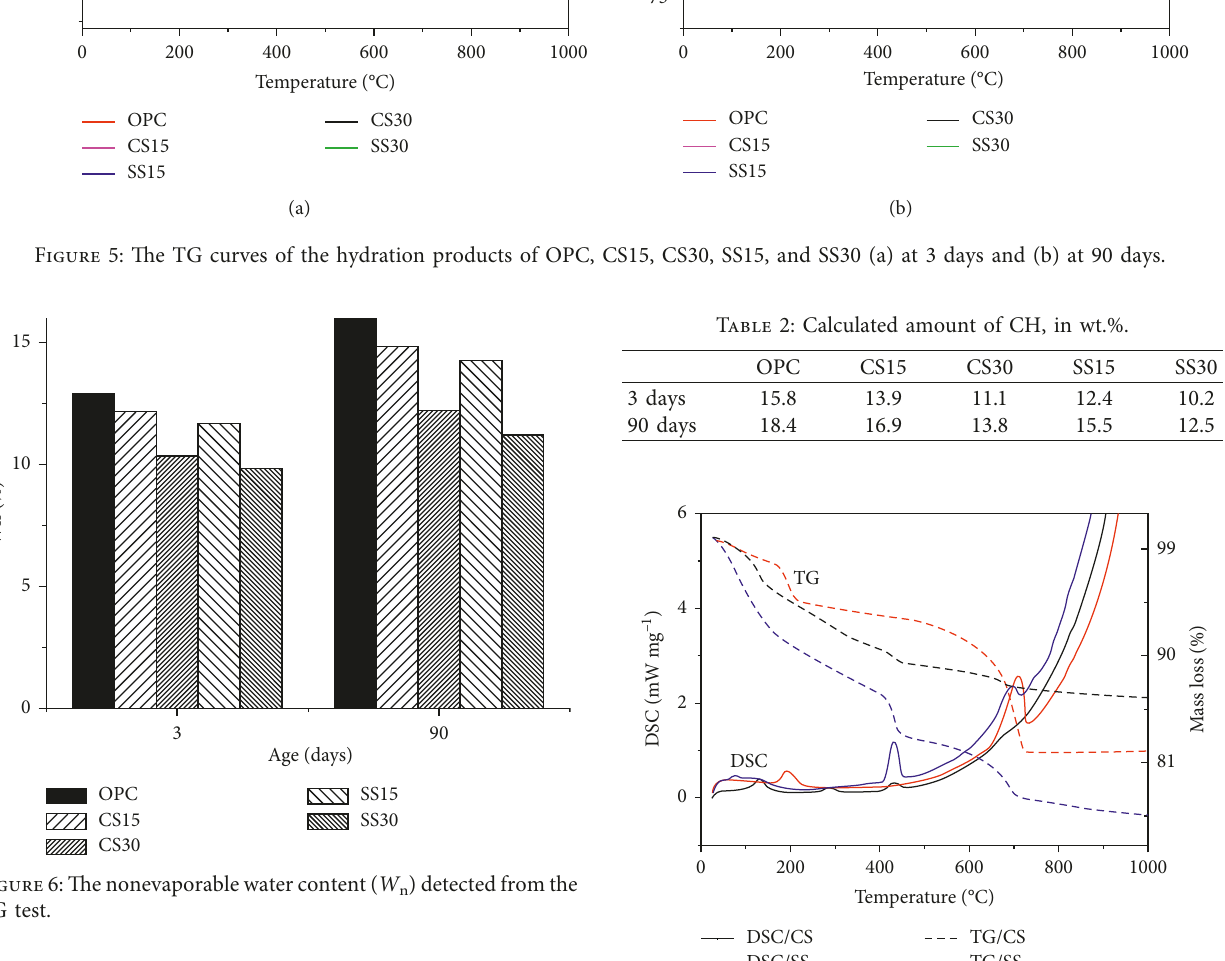
n ) detected from the